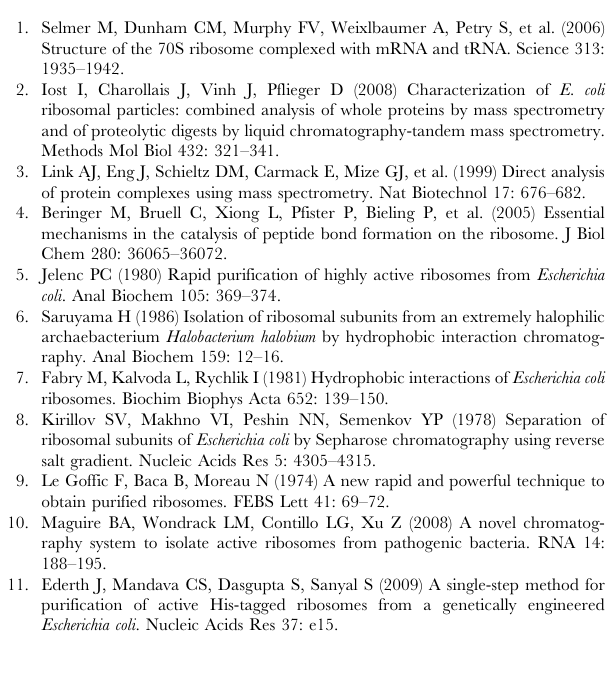
Figure S5 The composition of ribosomes is comparable for repeat FPLC runs and/or repeat samples. Ratios were obtained as described in Fig. S3. FPLC1 and FPLC2 are repeat runs of the same biological sample – actively growing Msm wild type. FPLC3 and FPLC4 were obtained from an independent sample of actively growing Msm wild type. Ratios for 30S peptides ( A ) and 50S peptides ( B ) are shown.